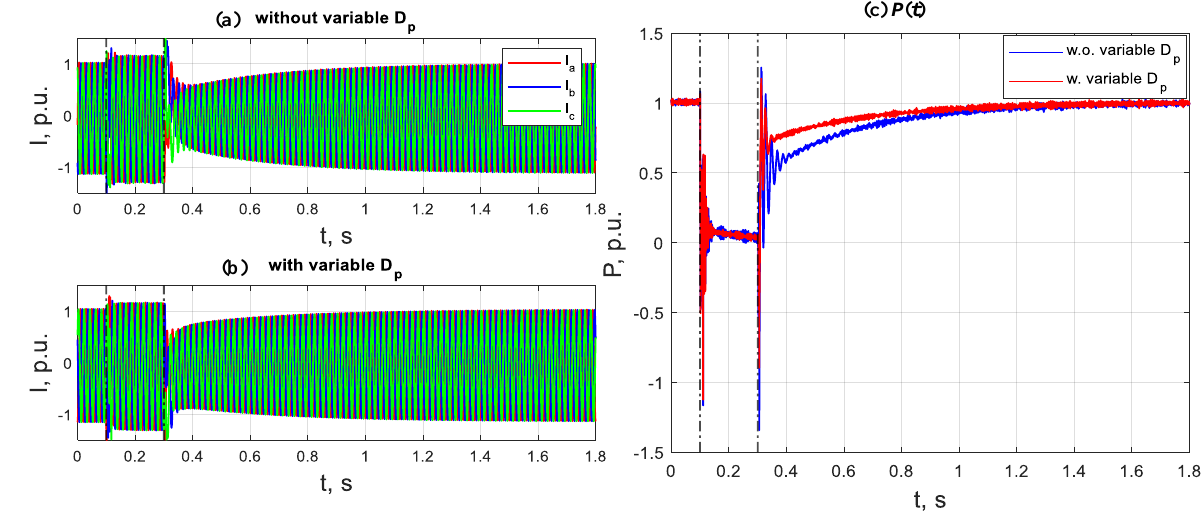
Figure 21. Auxiliary synchronization with and without variable 𝐷 p . The utilization of auxiliary synchronization with variable droop factor 𝐷 p (red curve) leads to the fastest active power recovery.